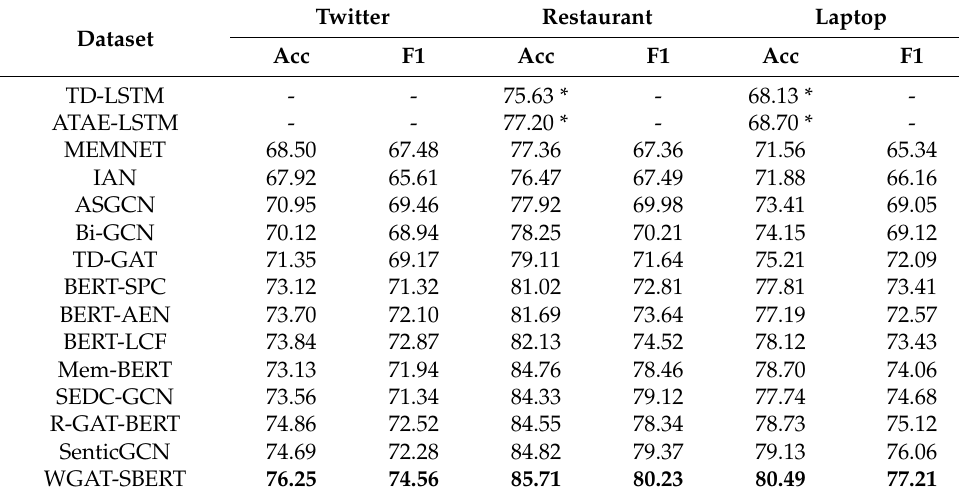
Table 3. Experimental results